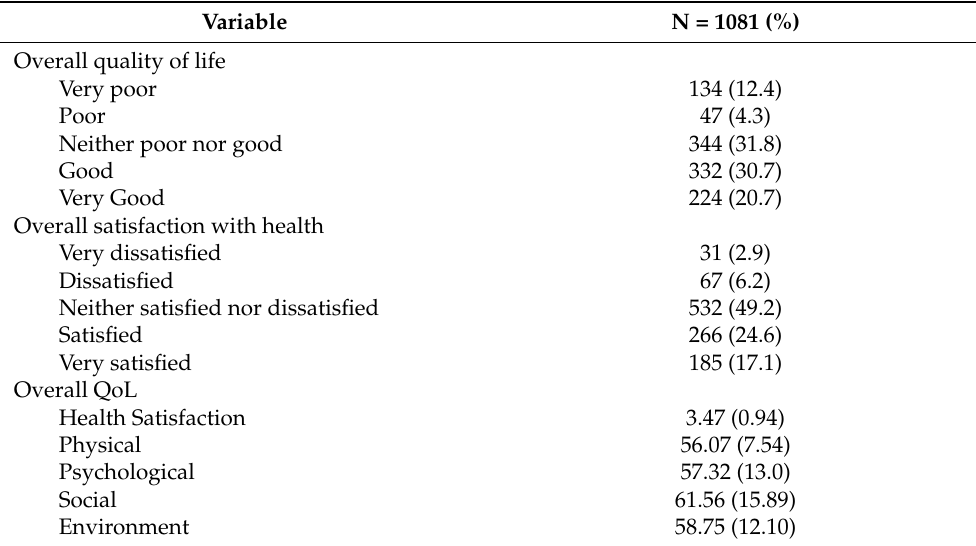
Table 2. The quality of life of caregivers assessed by WHOQOL-BREF.